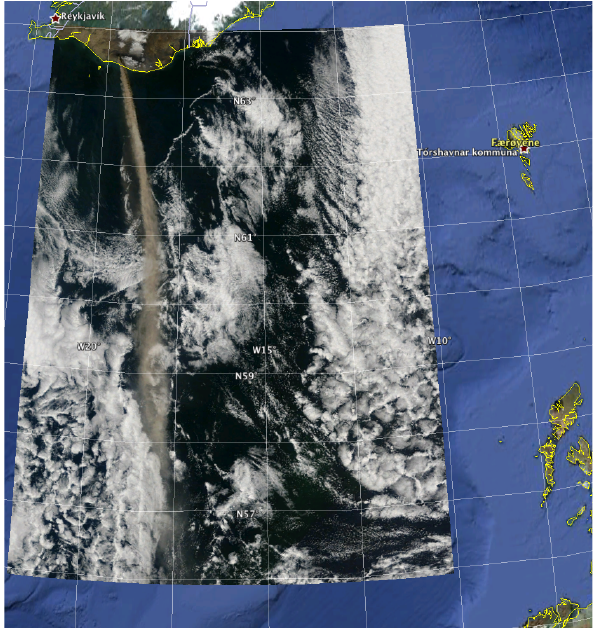
Fig. 3. MODIS true colour image of the Eyjafjallaj¨okull eruption on the 11 May 2010 at